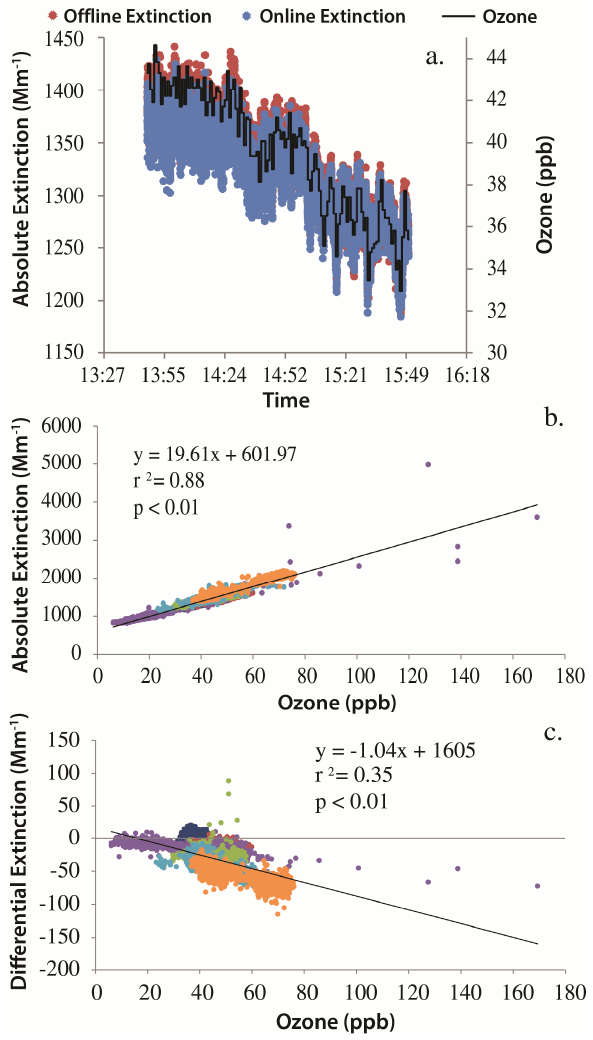
Fig. 5. Relationships between CRDS extinction measurements and O 3 concentrations: (a) CRDS extinction measurements on 29 February 2011 for two hours that show how extinction changes as a function of ambient O 3 concentrations. (b) Linear relationship between CRDS absolute extinction measurements and O 3 concen- tration during six days of measurements. (c) Same as (b) but show- ing differential extinction also affected by O 3 concentrations.